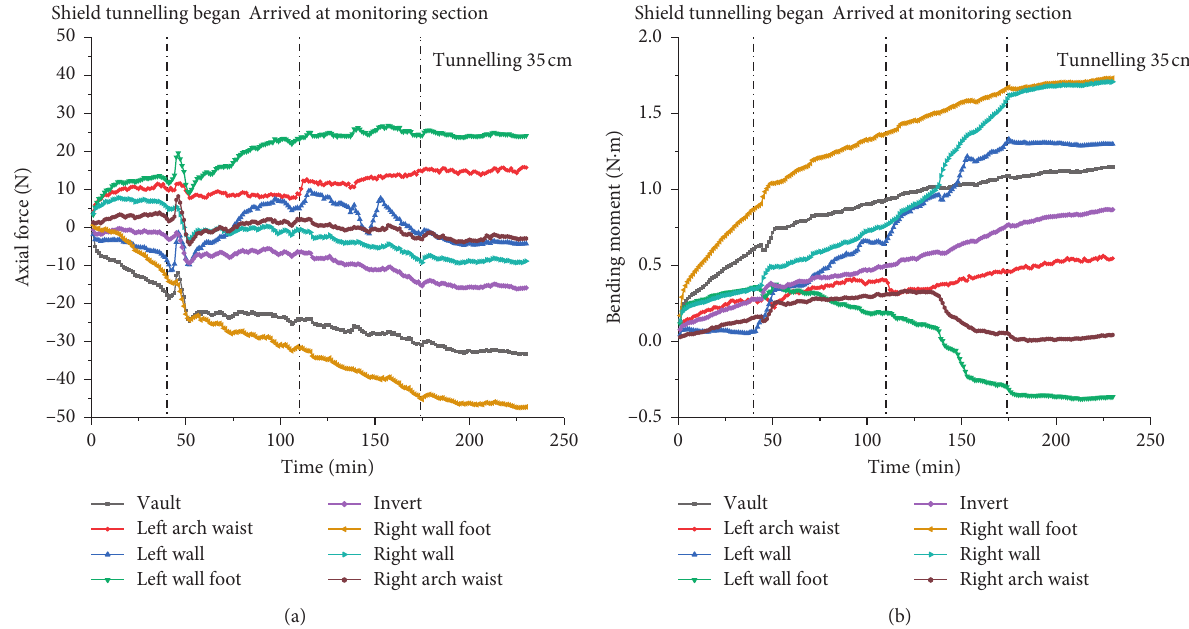
Figure 16: Time-history curve of internal force in initial support. (a) Axial force curve of initial support; (b) bending moment curve of initial support.